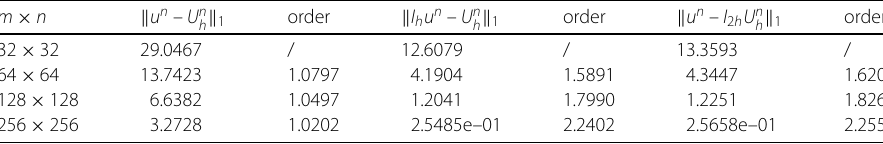
Table 9 Numerical results of u at t = 1 m × n